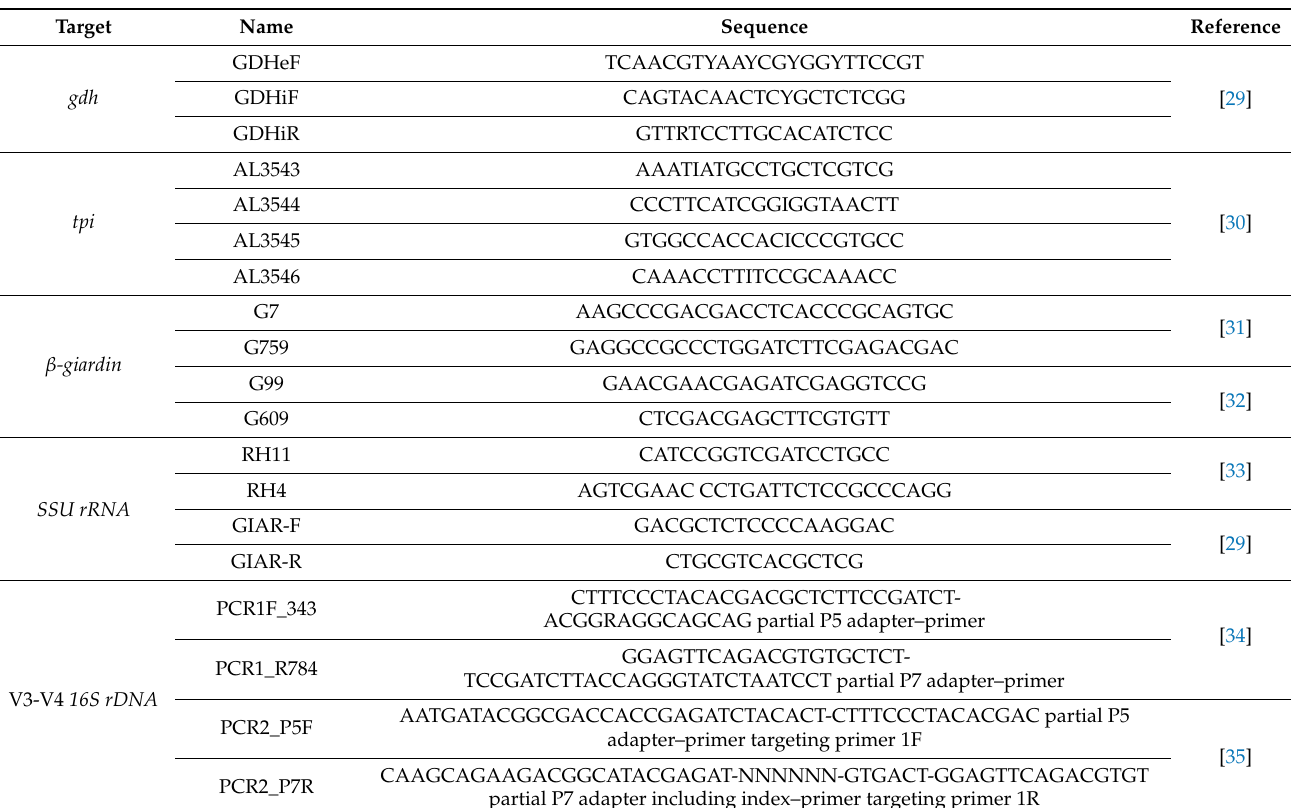
Table 1. Primers used in this study. Gdh , tpi , B-giardin, and SSU rRNA target Giardia , V3-V4 16S rDNA target the microbiota.